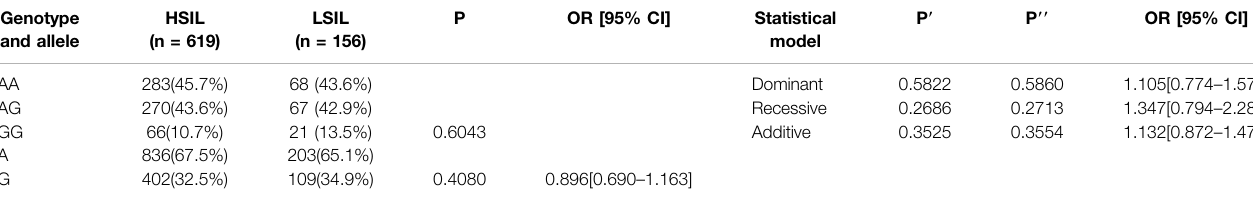
TABLE 6 | Comparison of genotypes and allele distribution frequencies between the HSIL group and LSIL group. Genotype and allele